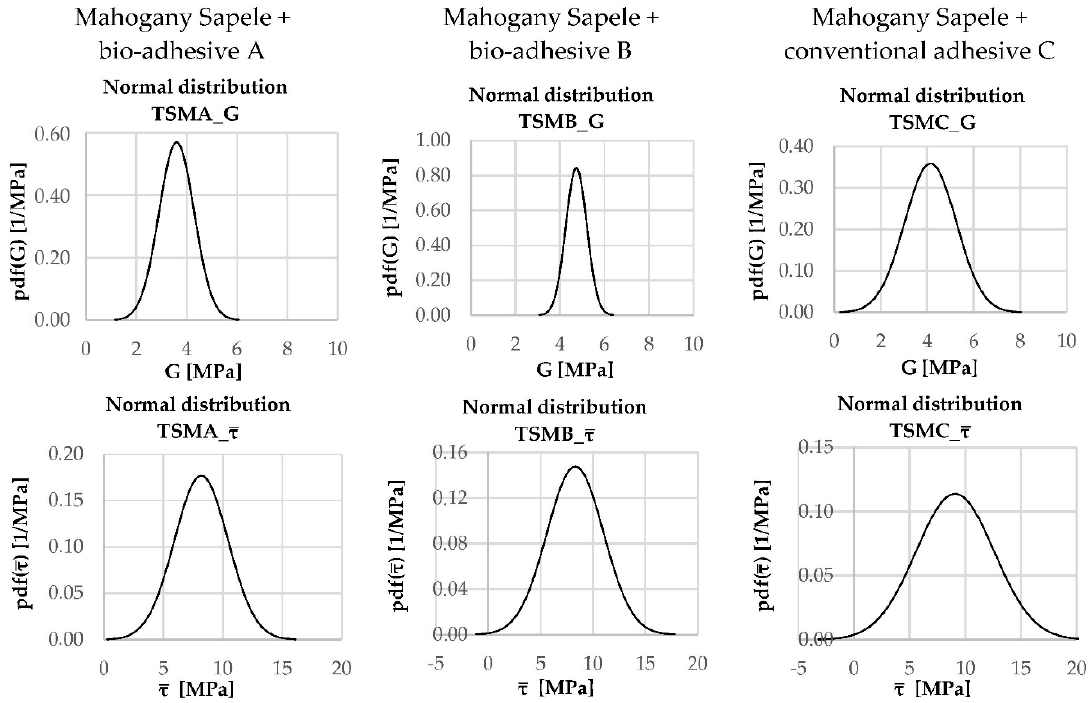
Figure A4. Statistical analysis for shear properties by tensile loading on Mahogany Sapele lap joint specimens.